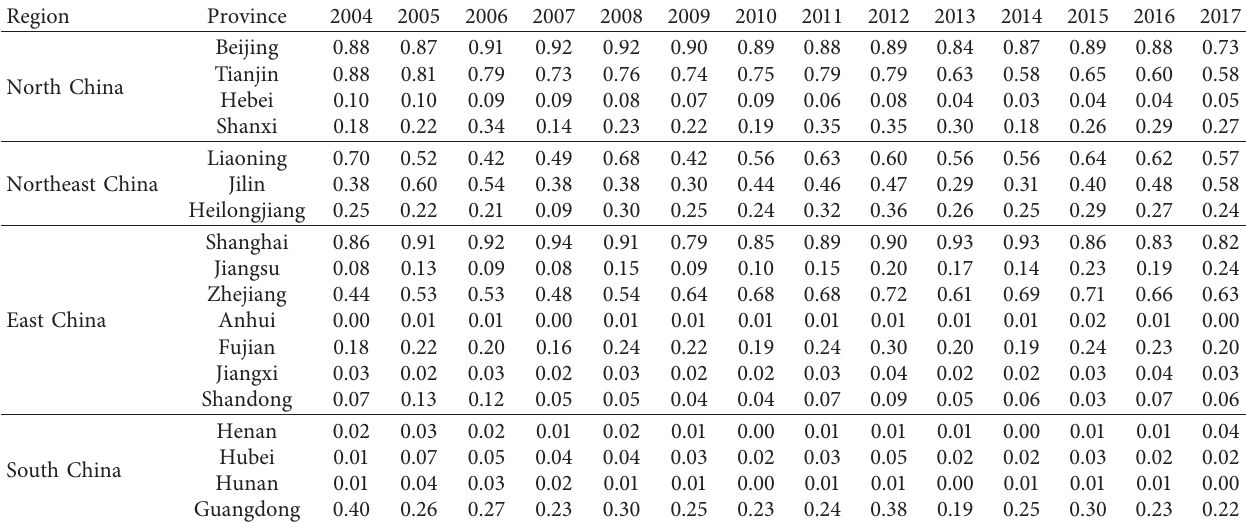
Table 5: Green finance development levels of each province and city from